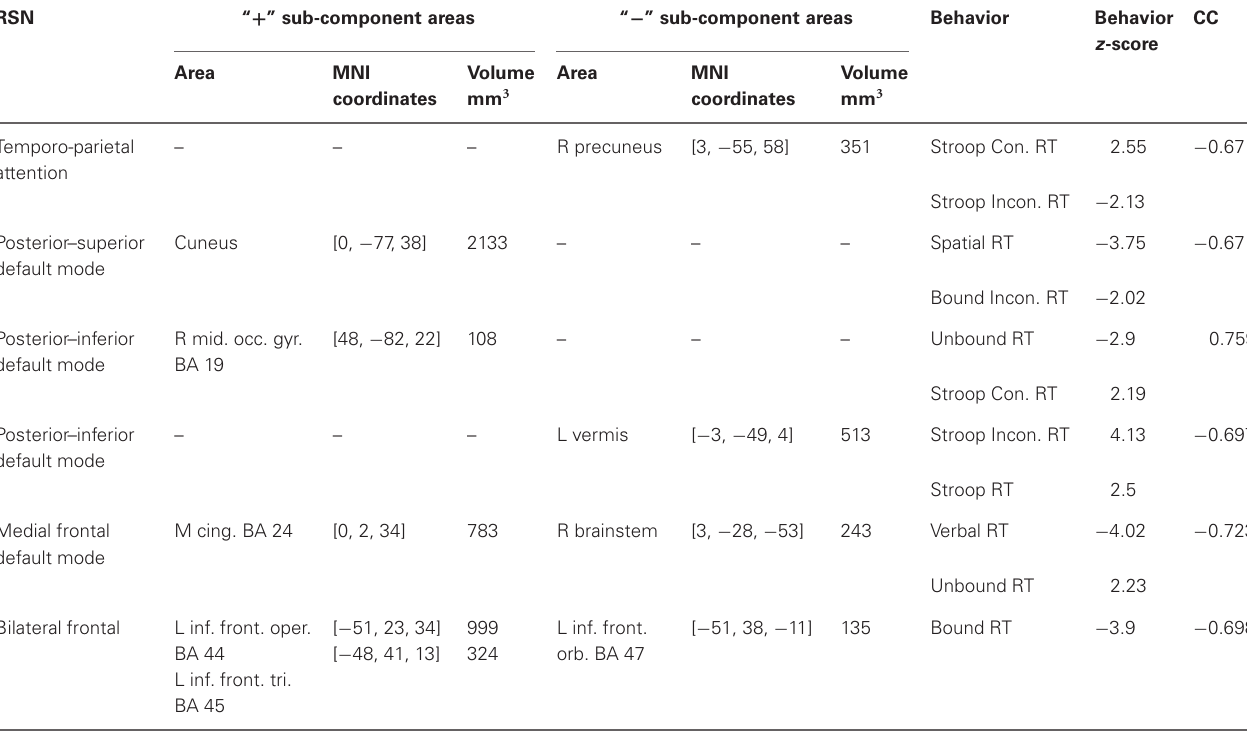
( Figure 5 ). Greater connectivity of mid-cingulate cortex and less connectivity of the brainstem to the medial frontal default mode network is negatively covaried to faster response time in the verbal working memory task and slower response time in the unbound working memory task, which requires the simultaneous retention of separate spatial and verbal information. BILATERAL FRONTAL NETWORK A significant negative correlation (CC = − 0 . 70) was found between a behavioral component including response time in the bound working memory task ( z = − 3 . 9) to spatial clusters in the left inferior frontal gyrus ( Table 2 ). The spatial component included a 135 mm 3 cluster with negative loading in the left frontal pars orbitalis, a 324 mm 3 cluster with positive loading in the left frontal par triangularis, and a 999 mm 3 cluster in the left frontal opercularis with positive loading ( Figure 5 ). This indi- cates that greater connectivity of the left frontal opercularis and triangularis, and less connectivity of the left frontal orbitalis, are negatively covaried with faster response time in the bound spatial and verbal working memory